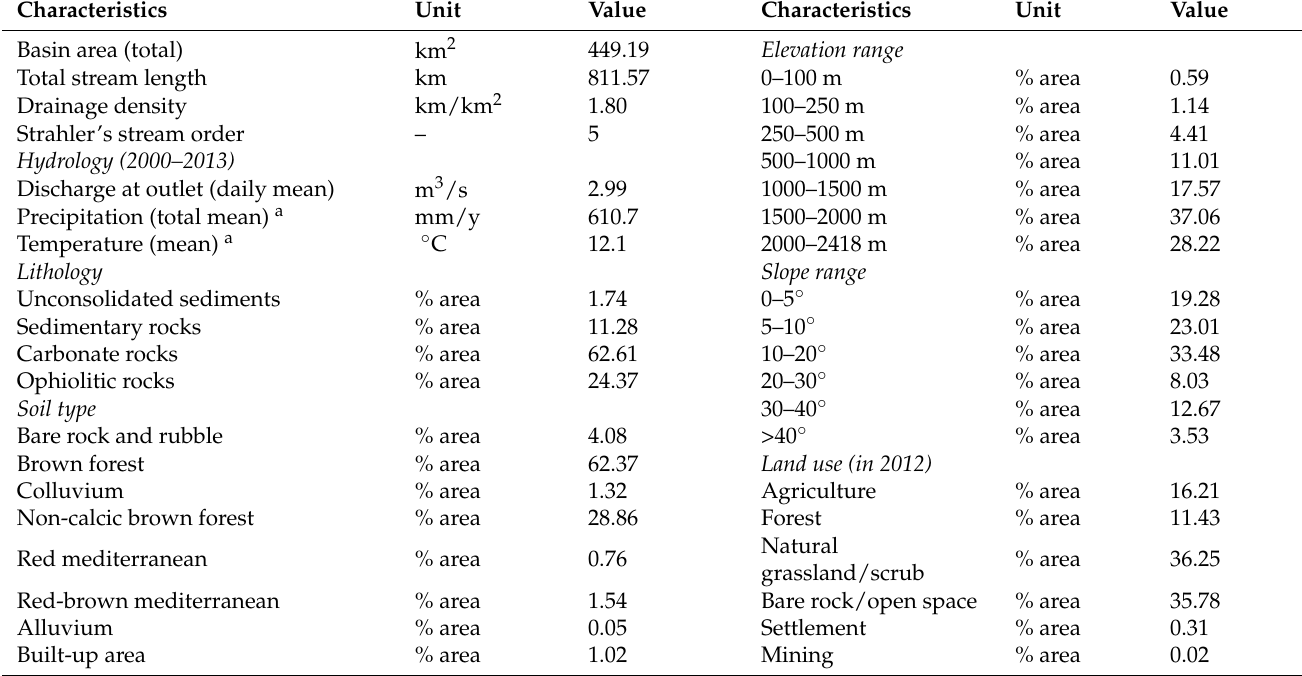
Table 1. Basic characteristics of the Alata River Basin (ARB) in Mersin, SE